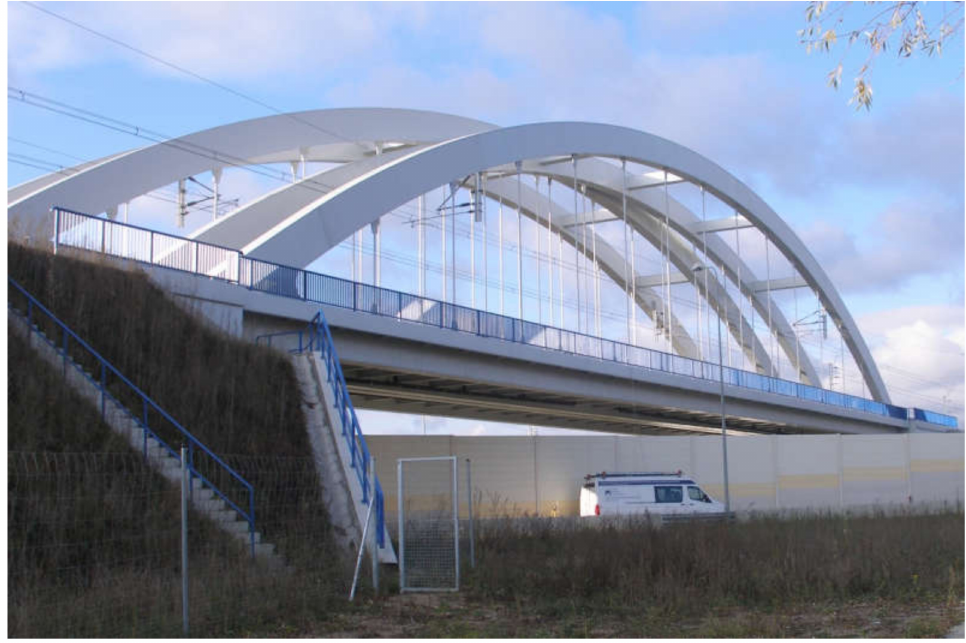
Figure 3. View of the tested bridge.